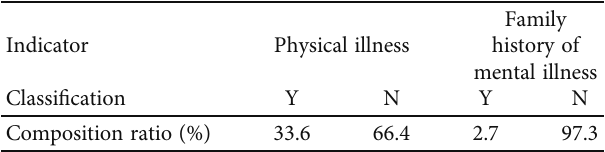
Table 2: Physical diseases of the elderly in the community in the past six months.